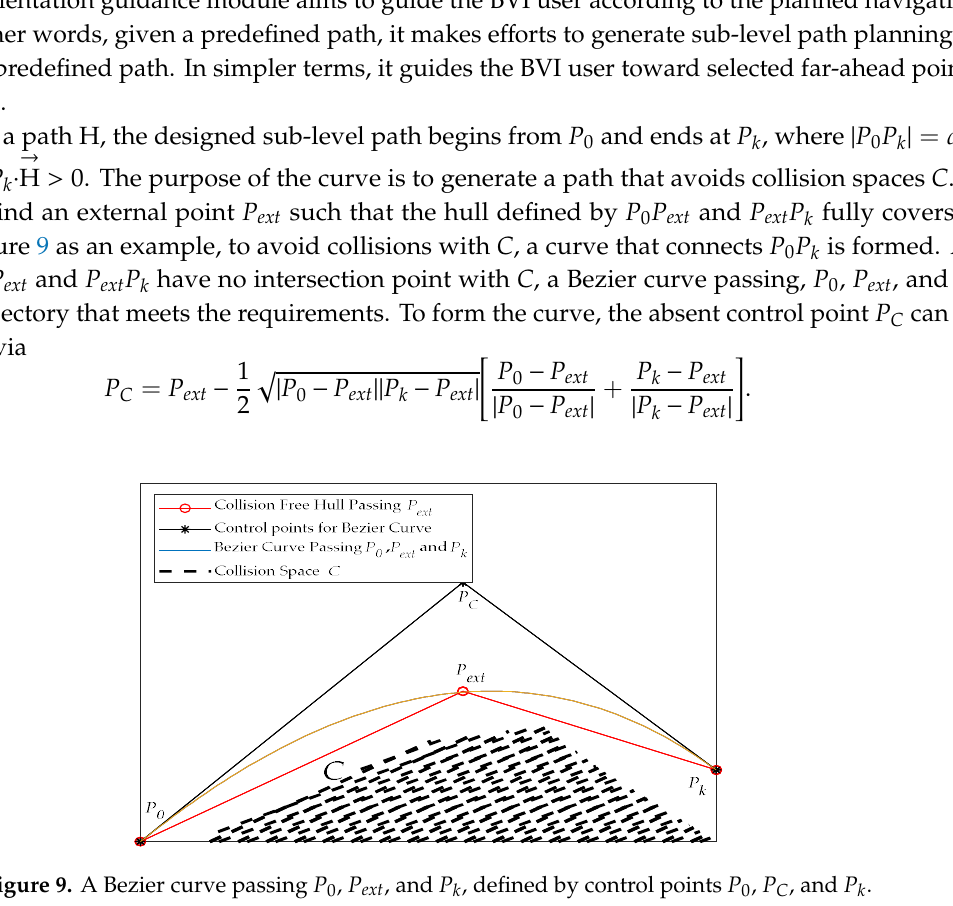
Figure 9. A Bezier curve passing P 0 , P ext , and P k , defined by control points P 0 , P C , and P k .